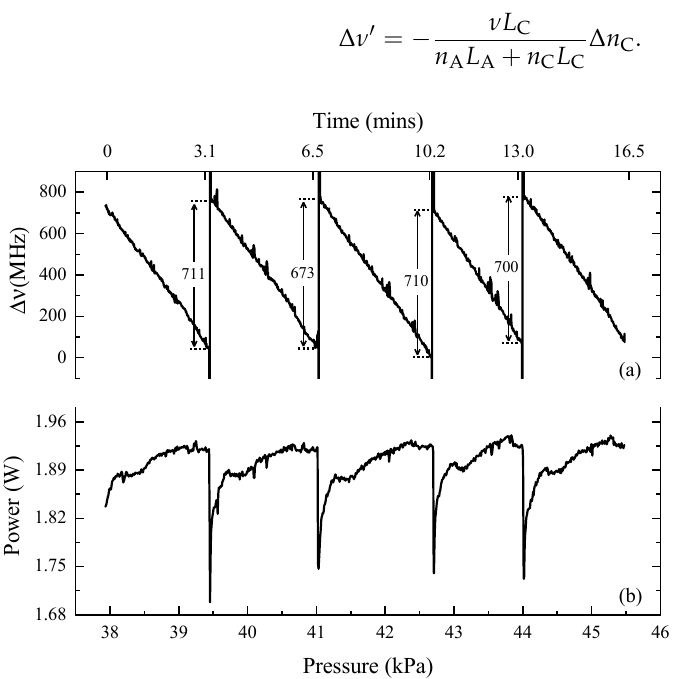
Figure 6. ( a ) Mode hops of signal beam provoked by air pressure and ( b ) corresponding idler power. The reference point of the frequency is 198.23992 THz.